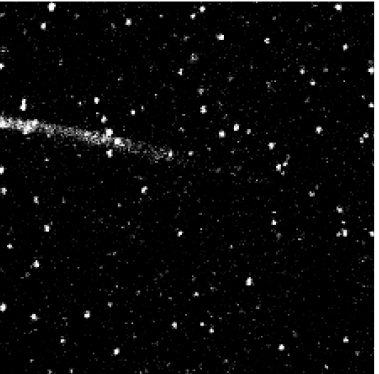
Figure 10. Image (40 × 40 (µm) 2 ) taken under a confocal fluorescence microscope of the sample prepared according to the procedure depicted in Figure 9. The bright spots are the individual SLAC molecules. Reprinted with permission from [43]. Copyright 2014 The American Chemical Society.